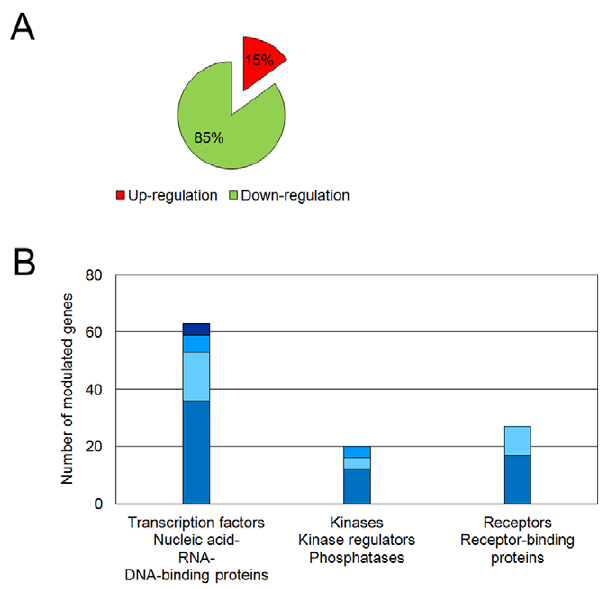
Figure 5. Analysis of the candidate mechanosensitive gene list. Gene expression levels of compressed samples were compared to uncompressed controls. DNA microarray analysis was performed on four independent pairs of compressed/uncompressed experiments. A list of 325 candidate genes was obtained by selecting transcripts with a fold change greater than 1.4 (p , 0.01). (A) Distribution of up- and down-regulated transcripts. (B) Functional annotation highlighting genes involved in gene expression regulation and in signal transduc- tion. Protein classes associated with modulated genes were pooled into three main groups: transcription regulation, phosphorylation cascade and receptor activity and the number of genes belonging to each protein class is shown. Within each group, protein classes are listed from most represented to least represented.